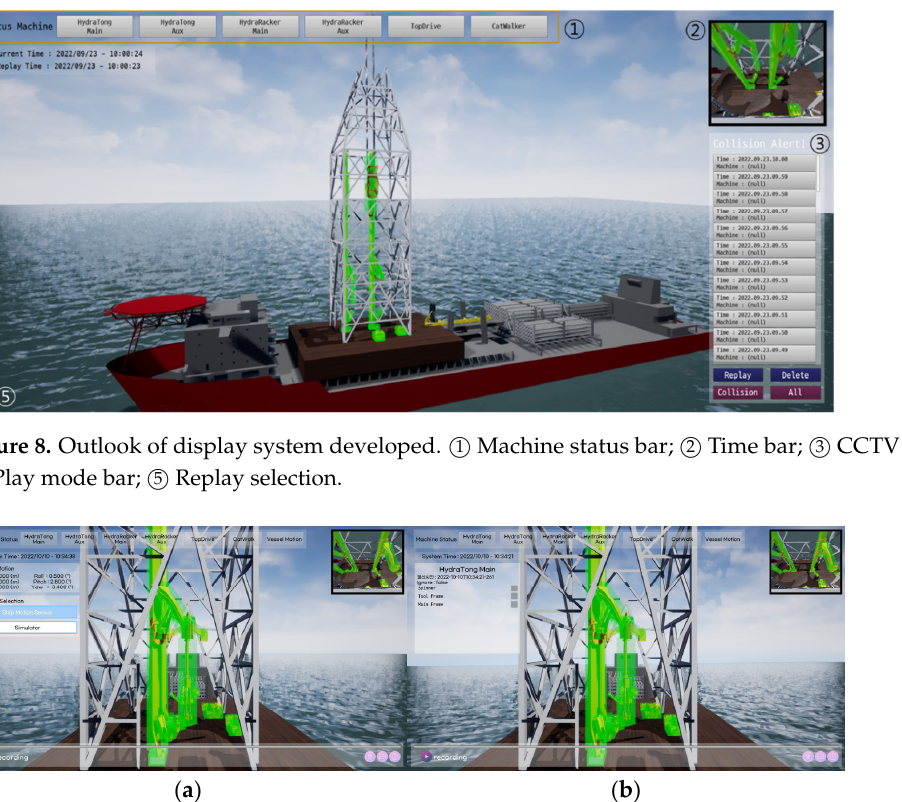
Figure 10. Collision alert bar is activated. ( a ) Collision history is shown in the collision alert box. ( b ) A collision is selected, and the ‘Replay’ button initiates the replay. ( c ) Replay is in progress. ( d ) The user is moving the viewpoint during replay mode to see the event in more detail. The position of the camera showing the screen displayed on the CCTV window is fixed to the structure. The inspector can only zoom in or out or tilt the screen slightly. Therefore, only a limited field of view is available. Using the developed system, it is pos- sible to show the situation in which the accident scene can be checked by rotating the screen in the desired direction in the playback mode. At this time, when the relevant equipment is selected from the machine status bar, the data of the equipment are